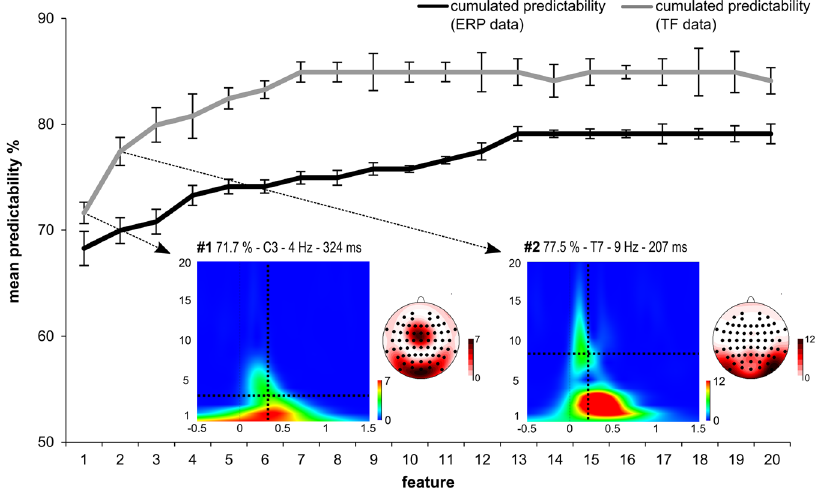
Figure 3. Results from the classification analysis using the TF-decomposed data (grey line). The mean predictability is given depending on the number of features. The grey curve in the figure shows the cumulative mean predictability. The error bars represent the 99% confidence level bounds. The black curve showing the cumulative predictability using ERP data is given for comparison. As can be seen the confidence bounds were not overlapping for the first and the second feature (grey curve). The TF plots of the first and the second feature are also shown. The dashed vertical lines in these plots show the time point/frequency (feature) at the respective electrode site (C3 for the first feature and T7 for the second feature). The scalp topography plots reveal the distribution of voltages for these features.